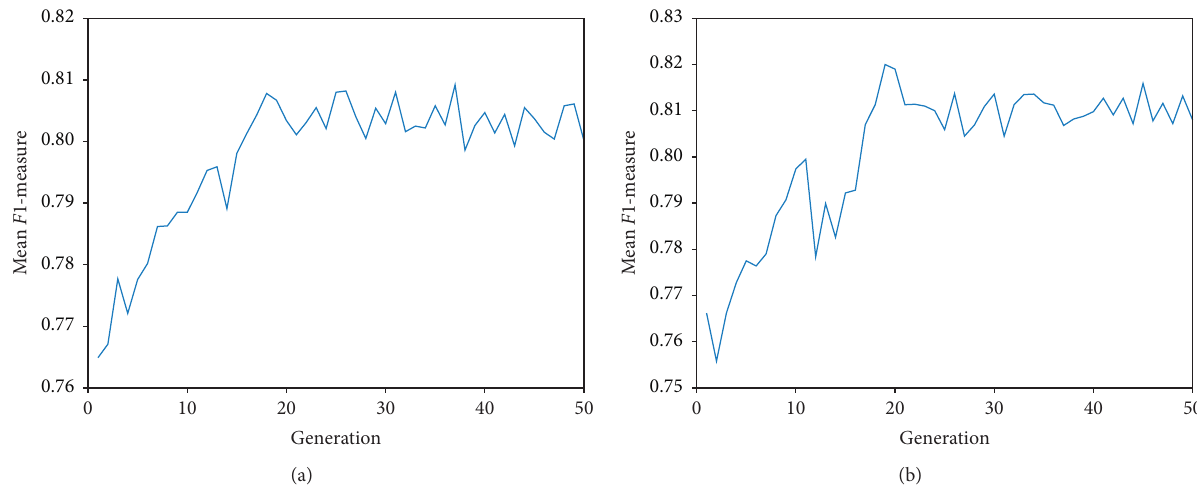
Figure 6: Using temporary test set to calculate fitness. (a) Temporary test set. (b) Verification